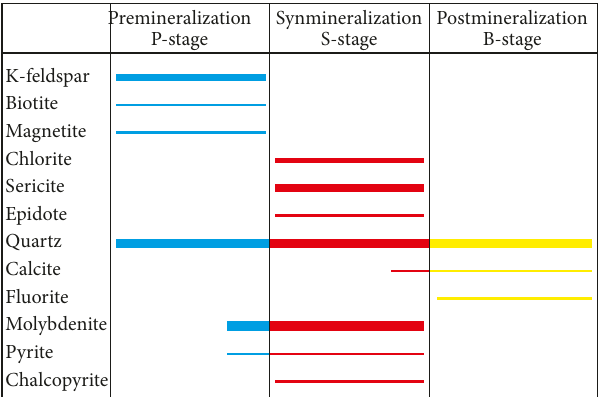
Figure 4: Schematic paragenetic sequence of the Haisugou Mo